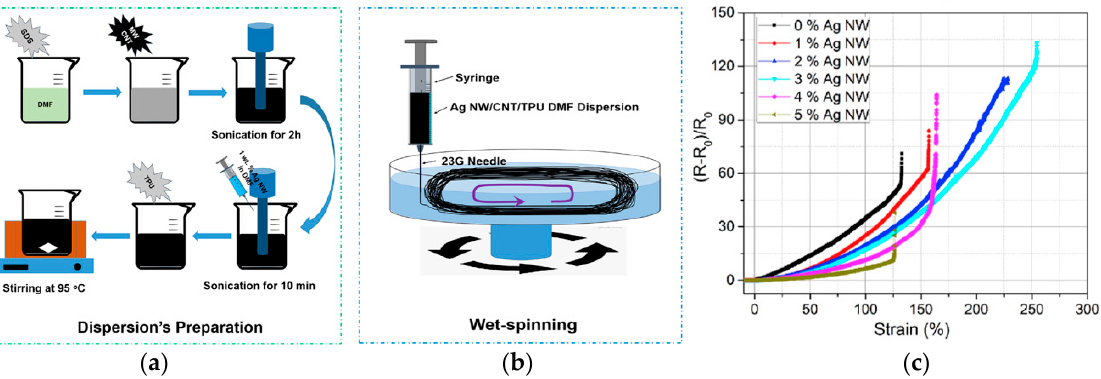
Figure 2. ( a ) Suspension preparation process; ( b ) AgNW/MWCNT/TPU spinning process; ( c ) the relative change resistance–strain curve of the fiber strain sensor with different AgNW contents [73].